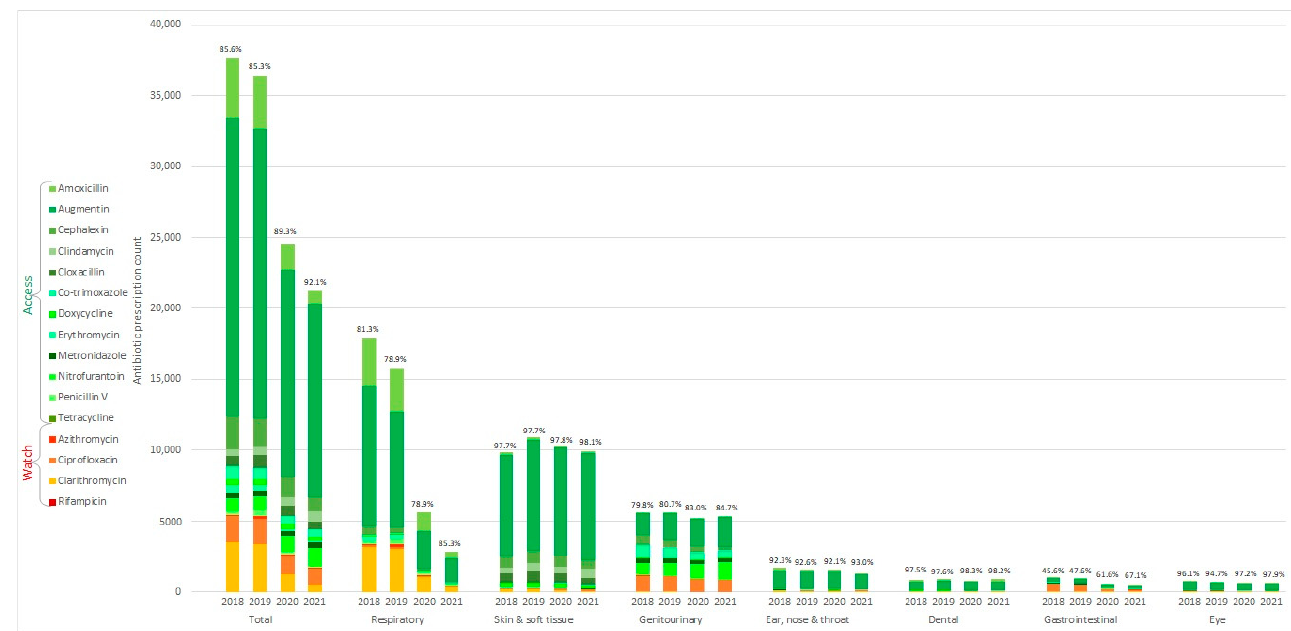
Figure 3. Oral antibiotics classi fi ed according to WHO AWaRe, 2018–2021.